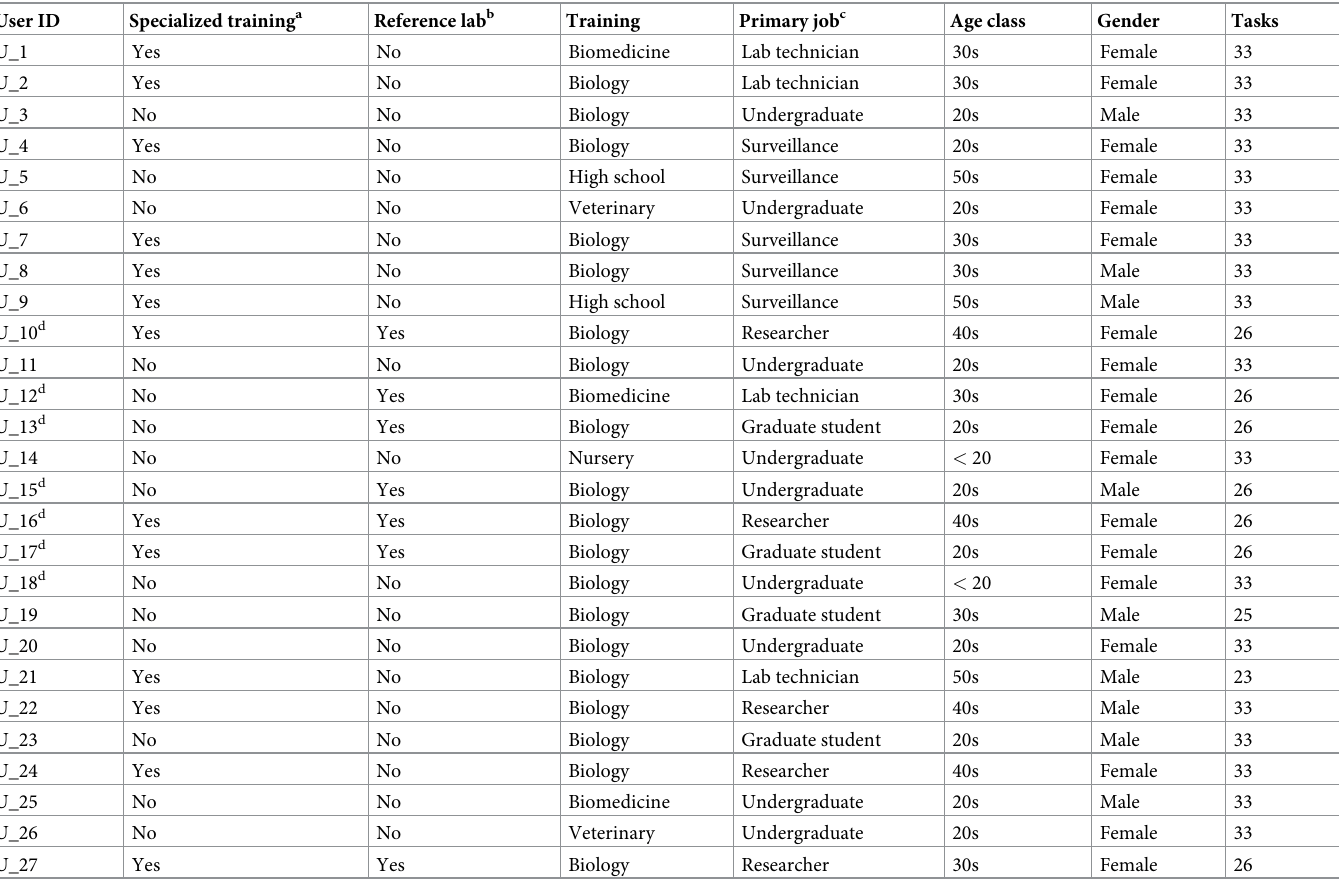
Table 1. T RIATO D EX volunteer users: User characteristics and number of identification tasks completed in the assessment of T RIATO D EX performance. User ID Specialized training